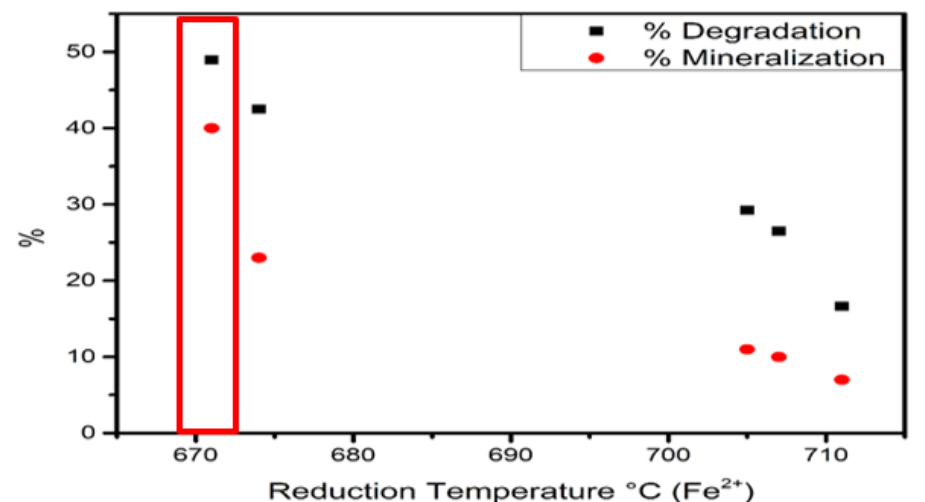
Figure 17. Fe 2+ temperature reduction vs. degradation and mineralization percentage. Table 9. Oxide–sulphide relation.